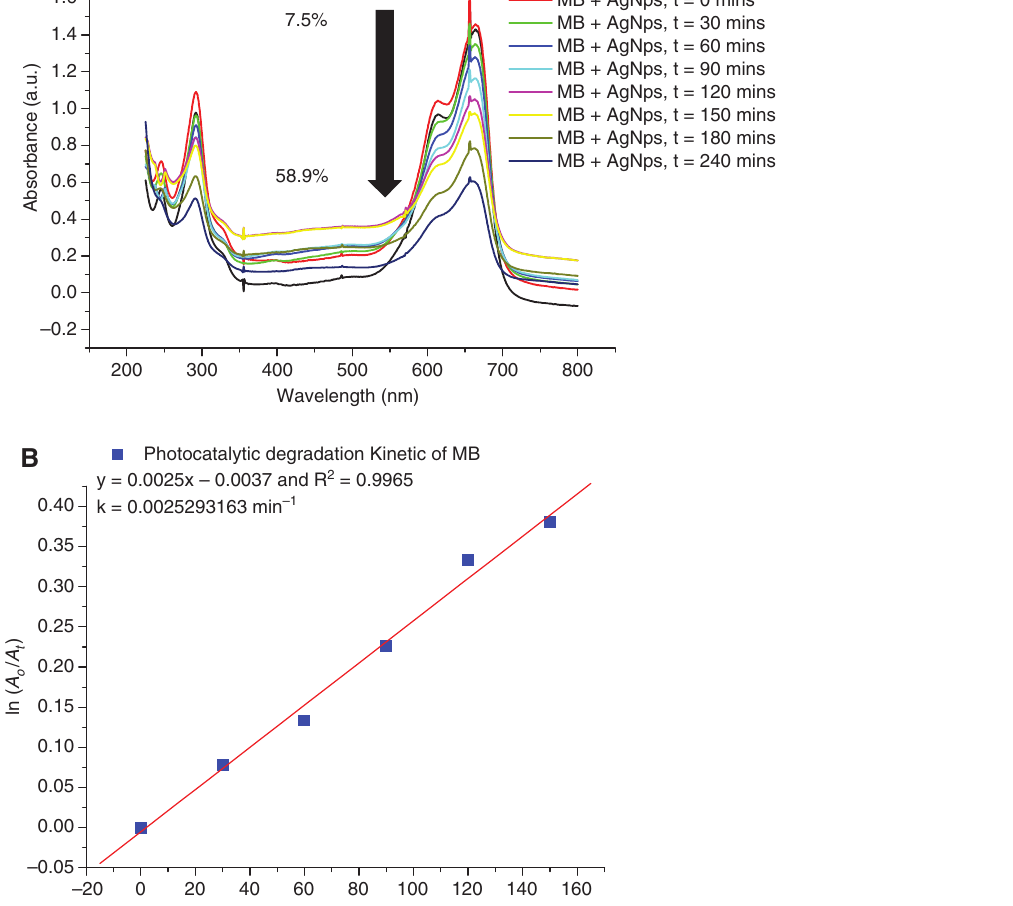
Figure 8: Methylene blue (A) degradation pattern and (B) ln( A